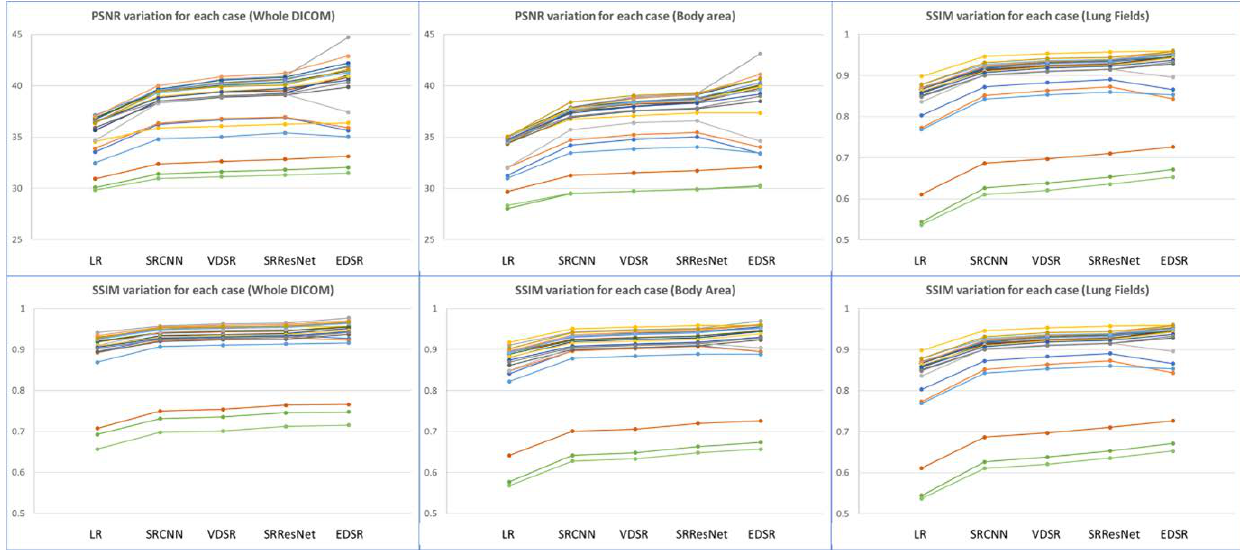
Figure 13. PSNR and SSIM variations for different ROIs and SR models. Each line represents the change in a single case. All results represent applying AI models to sagittal planes.